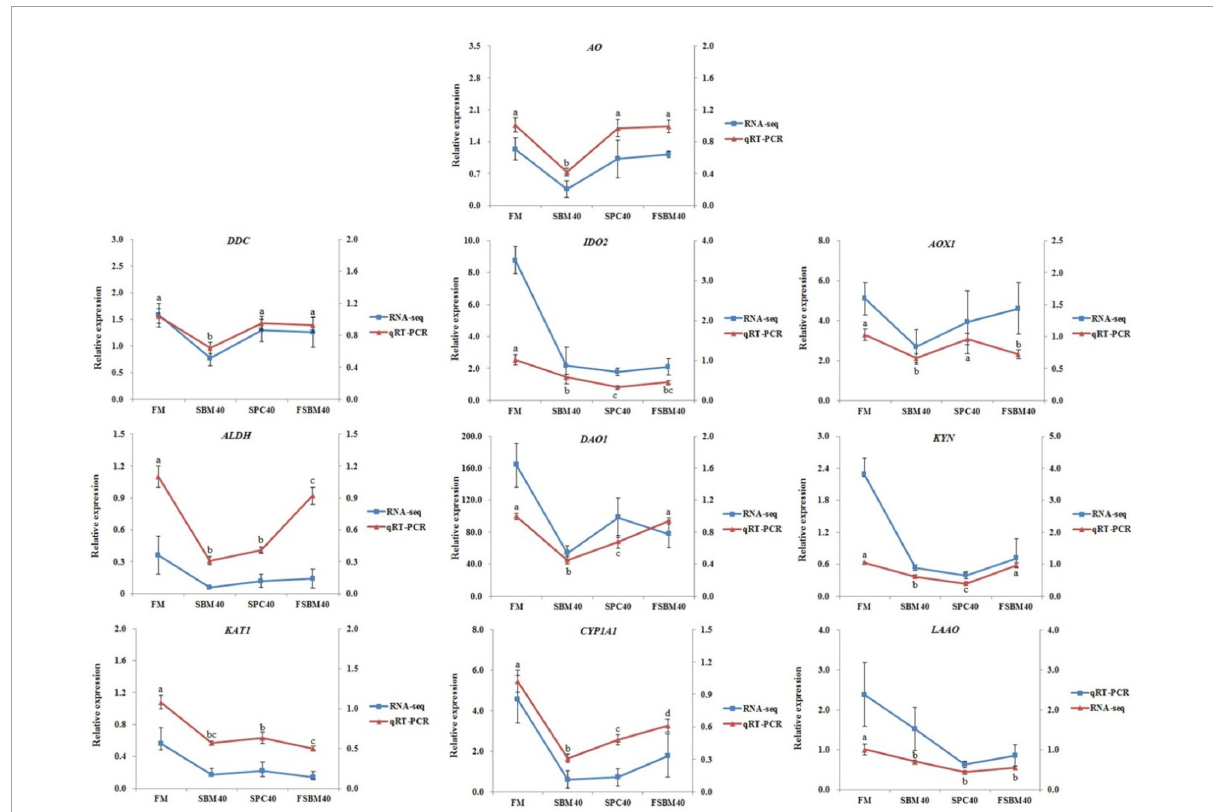
FIGURE5 The contrast of RNA-seq and RT-qPCR results and the expressions of the key genes in tryptophan metabolism pathway in hindgut were chosen to confirm the precision of “3 + 2” transcriptome sequencing. The relative expression degree in RNA-seq analysis was counted by FPKM value. Different letters distributed on the broken line represented significant variances between the groups at P < 0.05 ( n = 4).